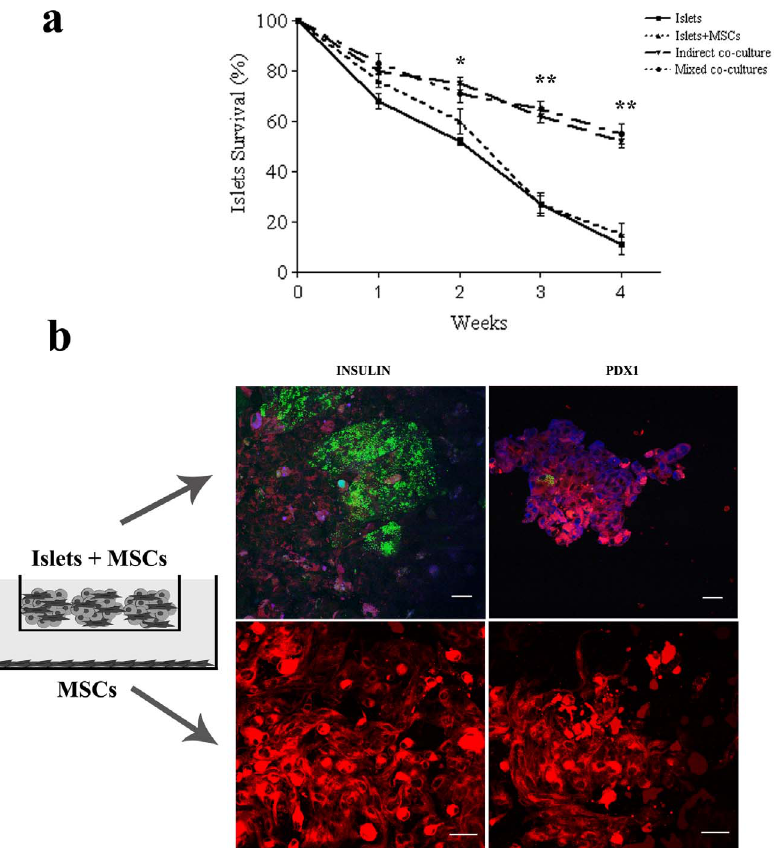
Figure 6. Mixed co-culture. Survival percentage evaluation of pancreatic islets indirectly co-cultured with MSCs. Calcein-positive cells were counted and the survival percentage was calculated up to 4 weeks of culture. Results are expressed as mean 6 SD of three independent experiments. * P , 0.05 ** Mixed co-cultures vs Islets, P , 0.001 Mixed co-cultures vs Islets and Mixed co-cultures vs Islets + MSCs. Insulin and Pdx1 positive cells in mixed co-cultures made up of pancreatic islets coated with MSCs (within the Transwell, upper panel), and MSCs adhering to the cover glass (lower panel). In green, calcein positive pancreatic islets. In red, MSCs stained with DiI. In blue, insulin or Pdx1 positive cells. Bar 30 m m.